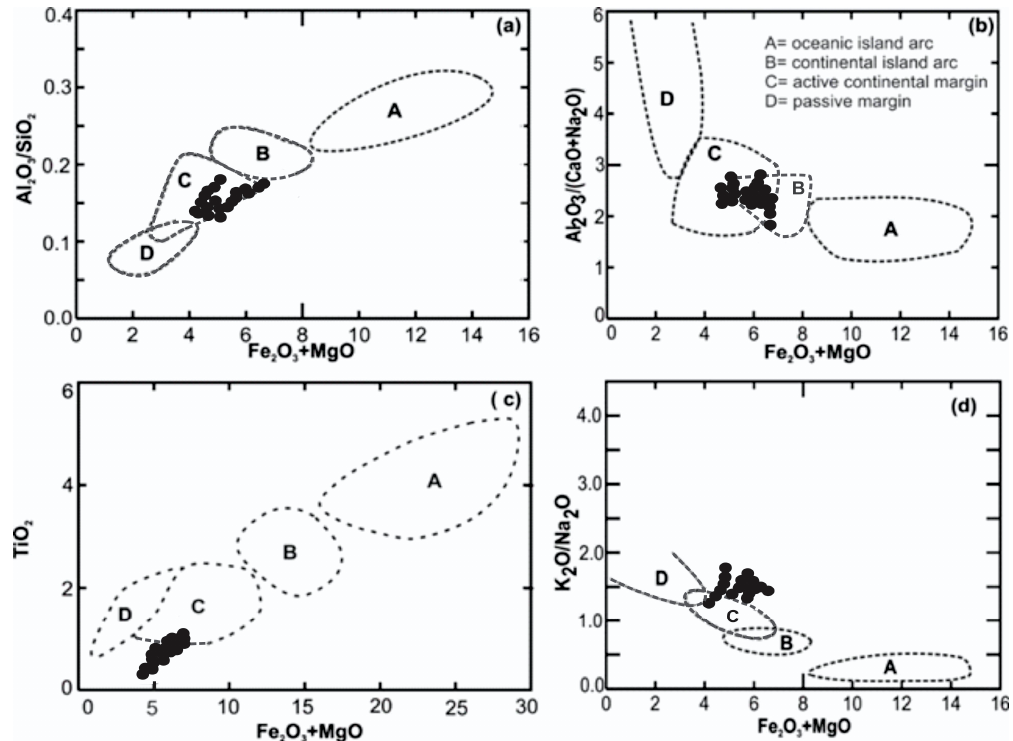
Figure 14. Tectonic ‐ setting discrimination diagrams for the Brahmaputra River sediments. Boundaries of fields are from Bhatia [57]. Brahmaputra River sediment samples are represented by the black dots. All data plotted in wt.%. ( a ) Al 2 O 3 /SiO 2 versus (Fe 2 O 3 + MgO) plot, ( b ) Al 2 O 3 /(CaO + Na 2 O) versus (Fe 2 O 3 + MgO) plot, ( c ) TiO 2 versus (Fe 2 O 3 + MgO) plot, ( d ) K 2 O / Na 2 O versus (Fe 2 O 3 + MgO) plot. All values are given in